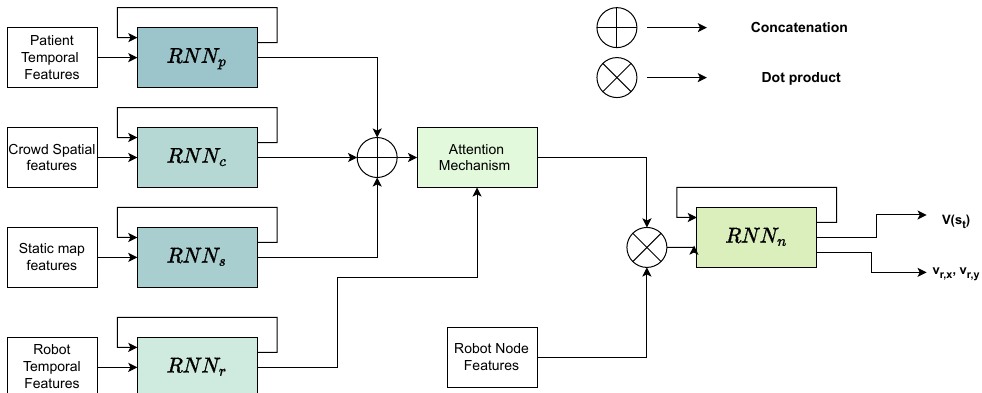
Figure 5. Proposed framework for the patient–robot co-navigation in environments with dynamic and static obstacles (Model